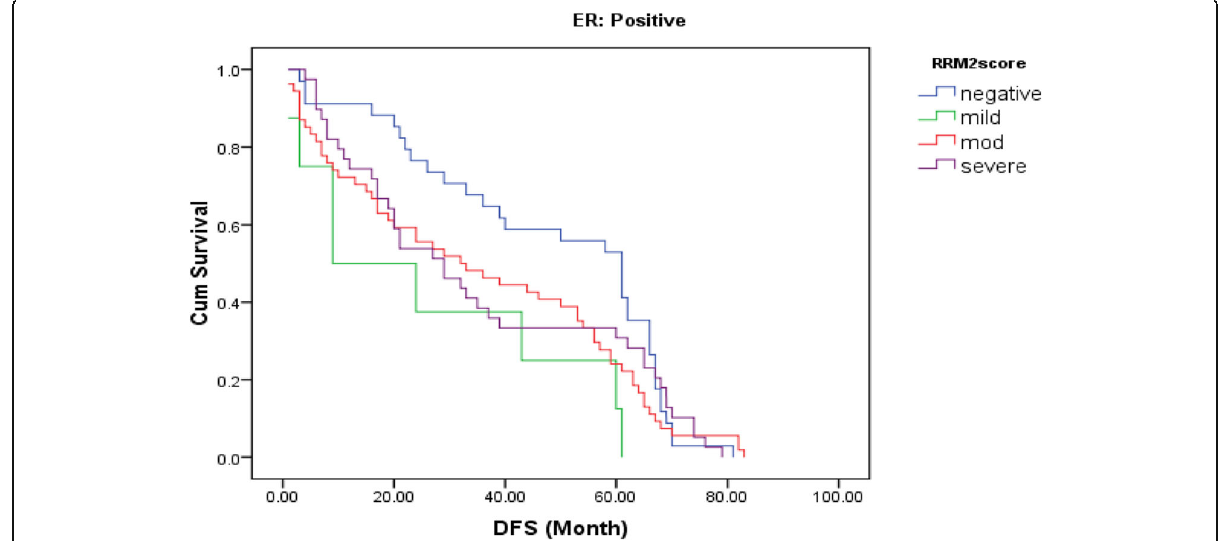
Fig. 4 A Kaplan – Meier plot of RRM2 expression and DFS in ER-positive series